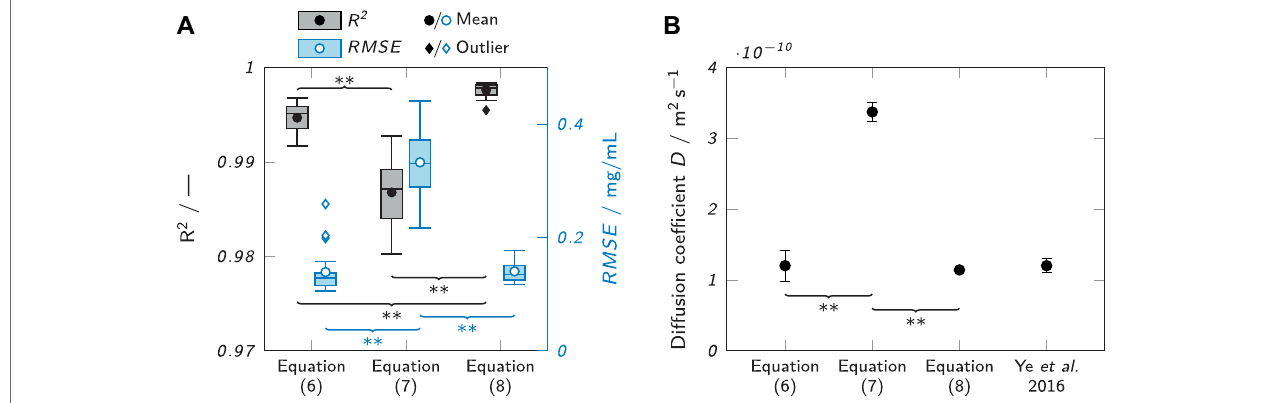
FIGURE5| Evaluation ofthesuitability ofdifferent fi tstodescribetheobservedconcentrationpro fi les. (A) Observed R 2 valueswhen fi ttingobservedconcentration pro fi les after 240 min with different analytical solutions of Fick ’ s second law ( Eqs 6 , 7 and 8 ). The box plots represent the median and the upper and lower quartile. The whiskers represent the most extreme value still within a 1.5-fold interquartile range (IQR) from the upper and lower quartile. All data points outside the 1.5-fold IQR are depictedasoutliers.Eachboxrepresents18samples( n =18). (B) Comparisonoftheobtained D estimatesforlysozymein0.5%(w/w)agarosewitheachotherand